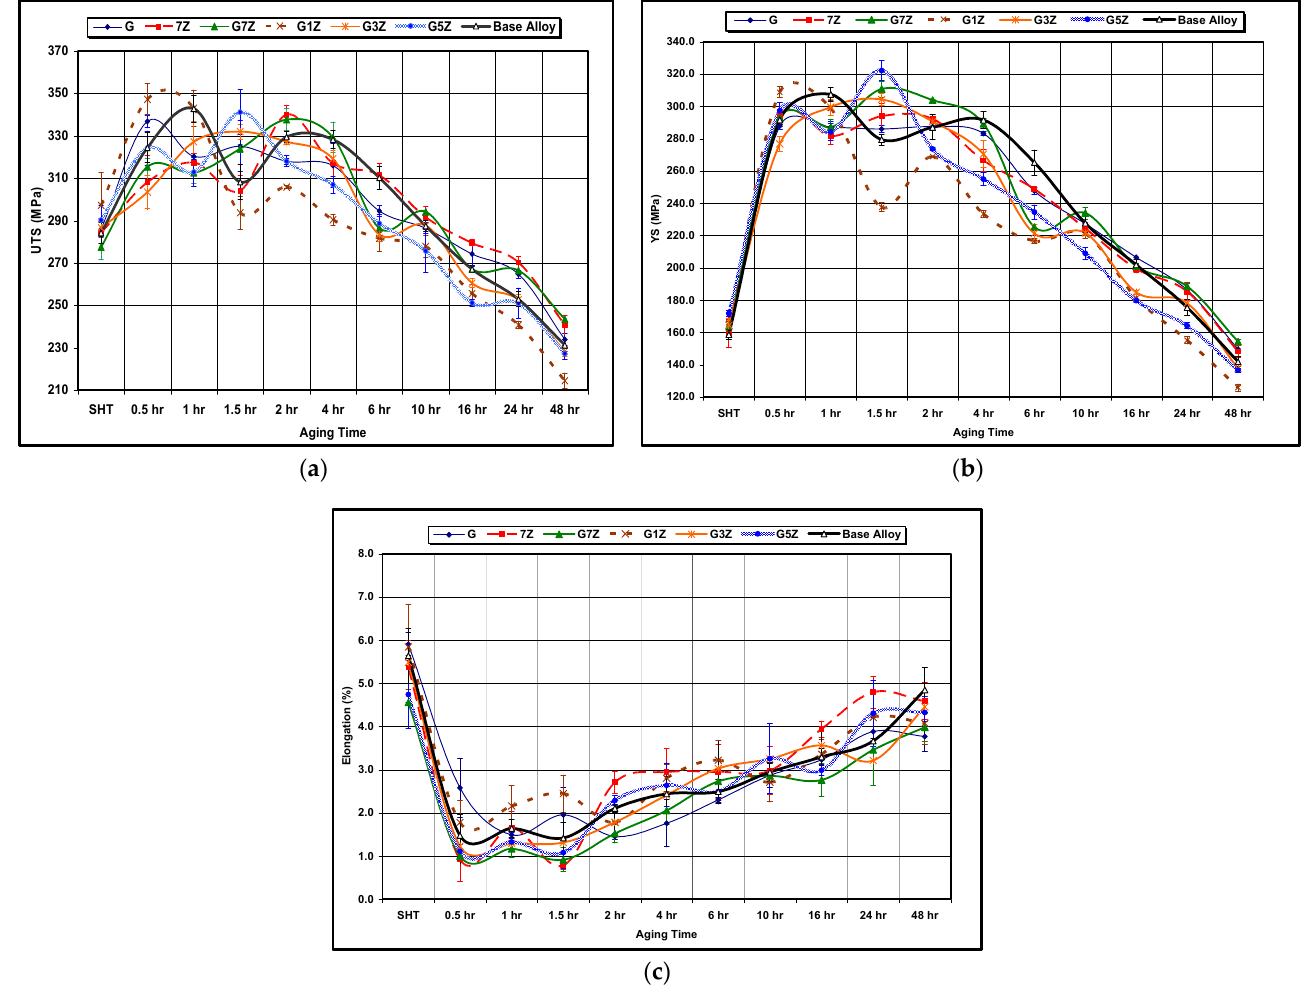
Figure 11. Effect of aging time on the tensile properties of the Zr-Ti alloy group at 220 °C aging temperature: ( a ) UTS, ( b ) YS, ( c ) %El.